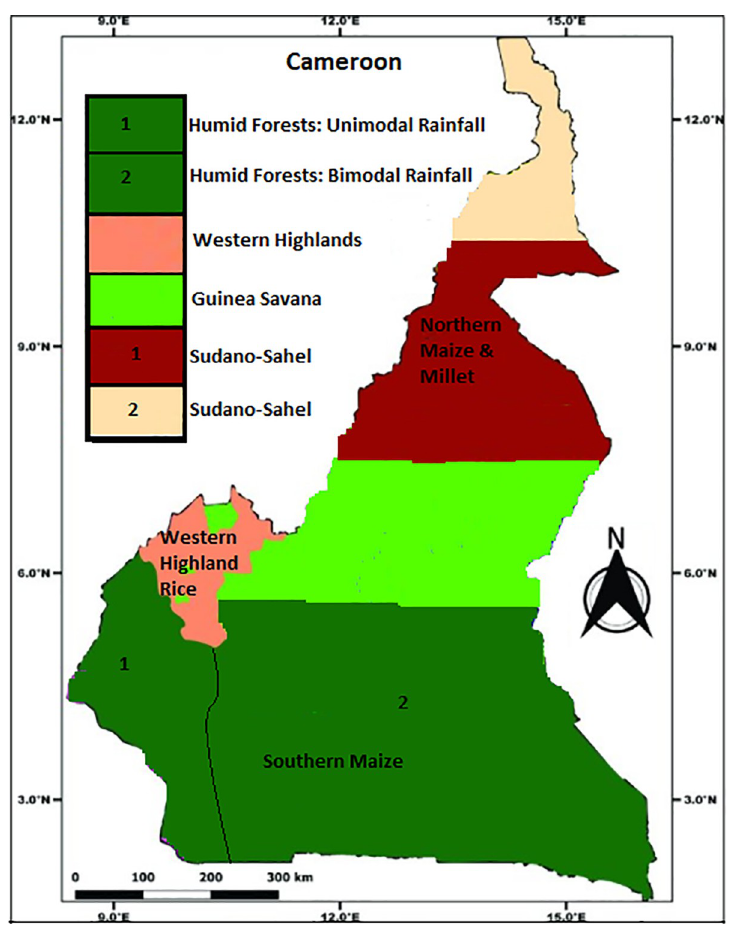
Fig 2. Map of Cameroon. Source: Authors’